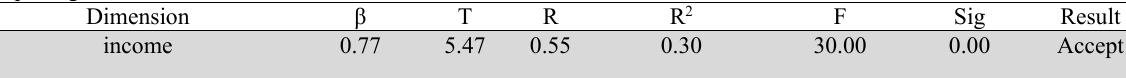
Simple regression results for consumer's income on brand selection